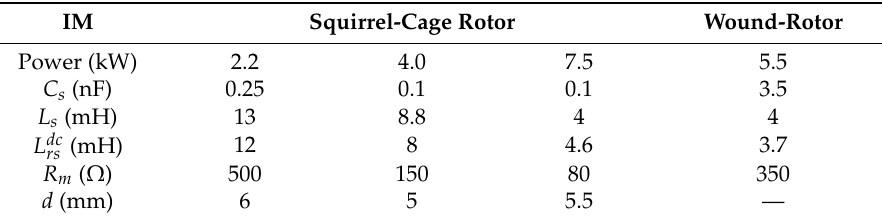
Table 4. Equivalent circuit parameters of tested induction motors.